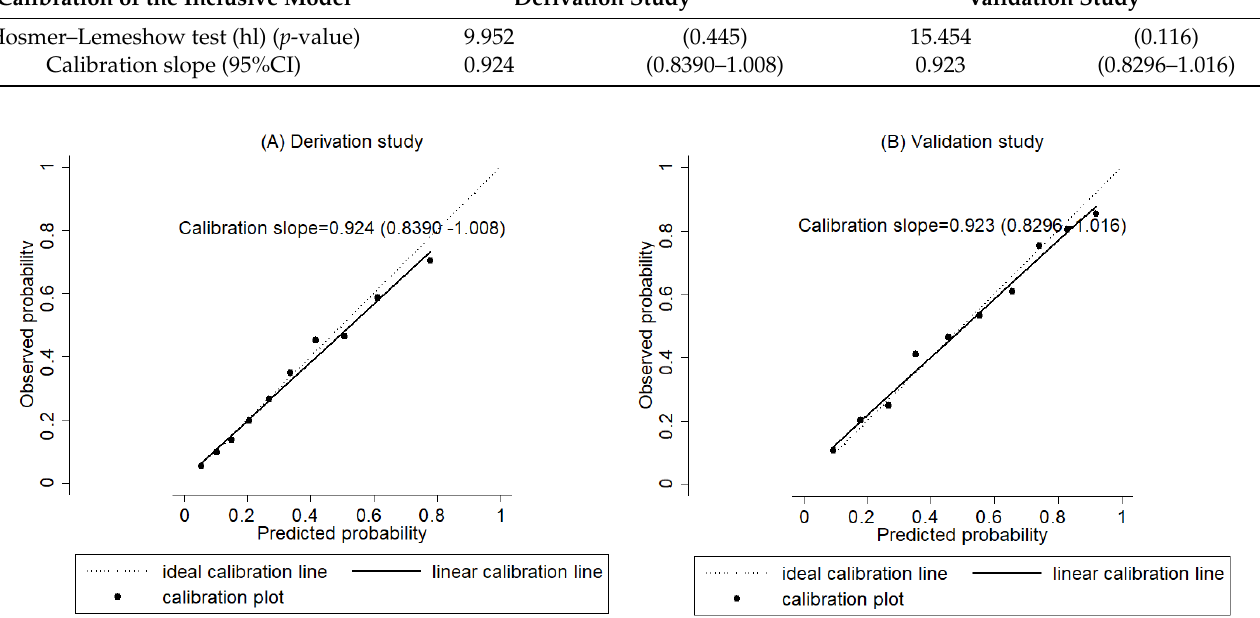
Table 5. Calibration in the deviation and validation study. Figure 1. Area under the curve (AUC) of the derivation ( A ) and validation ( B ) studies. In the derivation study, the inclusive model had a statistically significantly higher discriminatory ability than the other models. In the validation study, however, the environmental model was significantly more discriminative than the inclusive model.